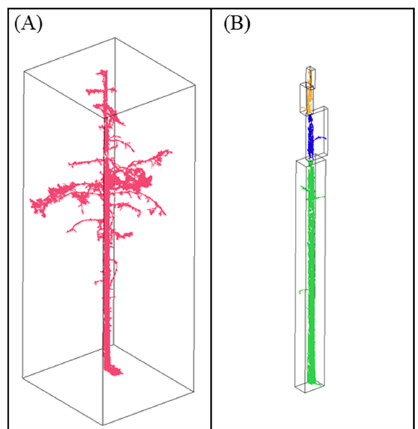
Figure 6. An example of two sets of stem segments produced by connected component segmentation using the same grid size of 1 cm. ( A ) The stem segments produced using the original point cloud. ( B ) The stem segments produced by the point cloud after branches and foliage points thinning. The colors were assigned to each segment randomly. The black boxes were the boundary of each segment. The figure shows that the stem segments of the point cloud after branches and foliage points thinning were separated from branches and foliage, which made the segment-based classification